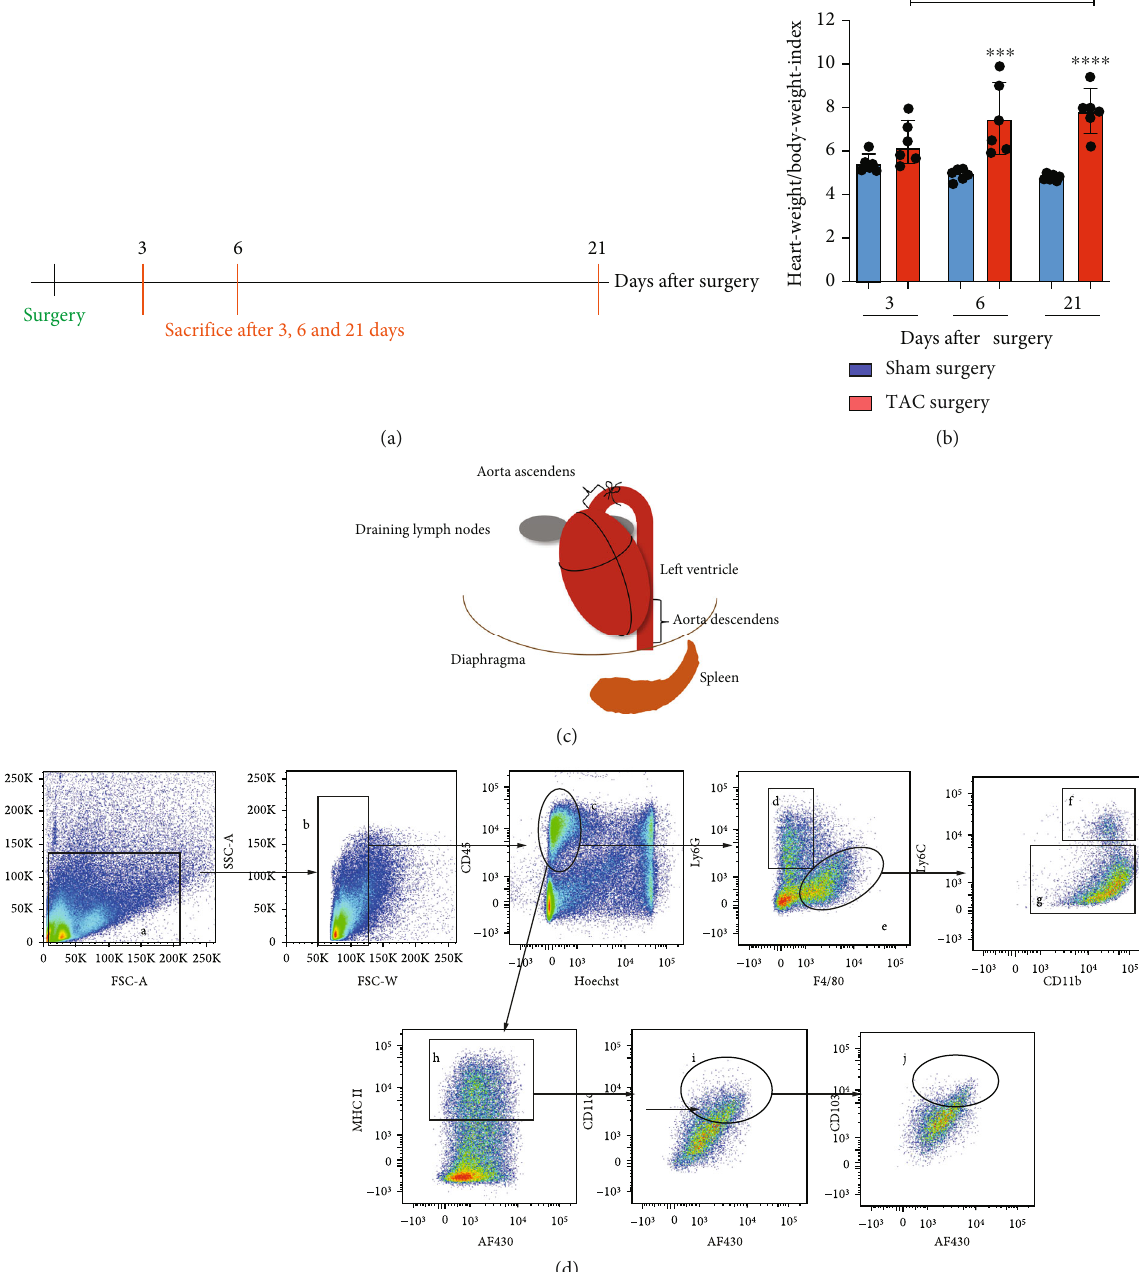
Figure 1: Methodological procedure and de fi nition of the immune cell subsets. (a) We sacri fi ced the mice 3, 6, and 21 days after TAC or sham surgery. (b) Heart-weight/body-weight-index in mg/g was calculated 3, 6, and 21 days after TAC or sham surgery. (c) In addition to the LV tissue, we analyzed the tissue of the aorta ascendens, aorta descendens, spleen, blood, and heart draining lymph nodes. (d) The gating strategy for fl ow cytometry analyses was performed as illustrated for the tissue of the aorta ascendens. All cell-like events (a) were isolated by using the forward scatter area versus sideward scatter area. Doublets were excluded using forward scatter area versus sideward scatter width (b). We de fi ned the living immune cells (c), using CD45 staining versus Hoechst staining. The CD45 + immune cells were further classi fi ed by staining for the surface markers Ly6G and F4/80 to determine neutrophils (d) and macrophages (e). Next, we checked for the Ly6C surface expression of the macrophage population as a function of CD11b to di ff erentiate between the Ly6C high (f) and the Ly6C low macrophages (g). We analyzed the DC compartment based on the population of the CD45 + cells (c) and stained for MHC-II to identify MHC-II + immune cells (h). We used CD11c as a function of the auto fl uorescence channel AF430 for the de fi nition of classical dendritic cells (i). The cDCs were further discriminated according to the CD103 surface expression